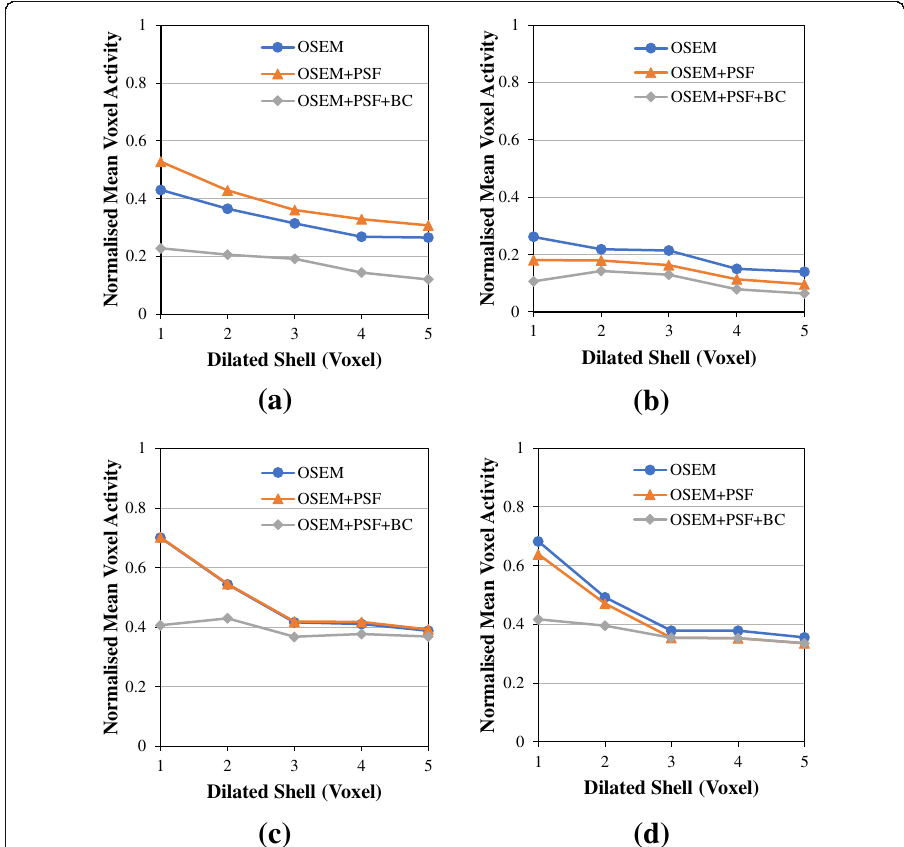
Fig. 12 Validating the effect and correction of spill-in effect using patient data. This figure shows the normalised mean values within the dilated shells surrounding the spleen at a 3 full iterations with no post- filter, b 20 full iterations with no post-filter, c 3 full iterations with a 4-mm Gaussian post-filter and d 20 full iterations with a 4-mm Gaussian post-filter. The mean activity values in the dilated shells were normalised with the mean activity in the